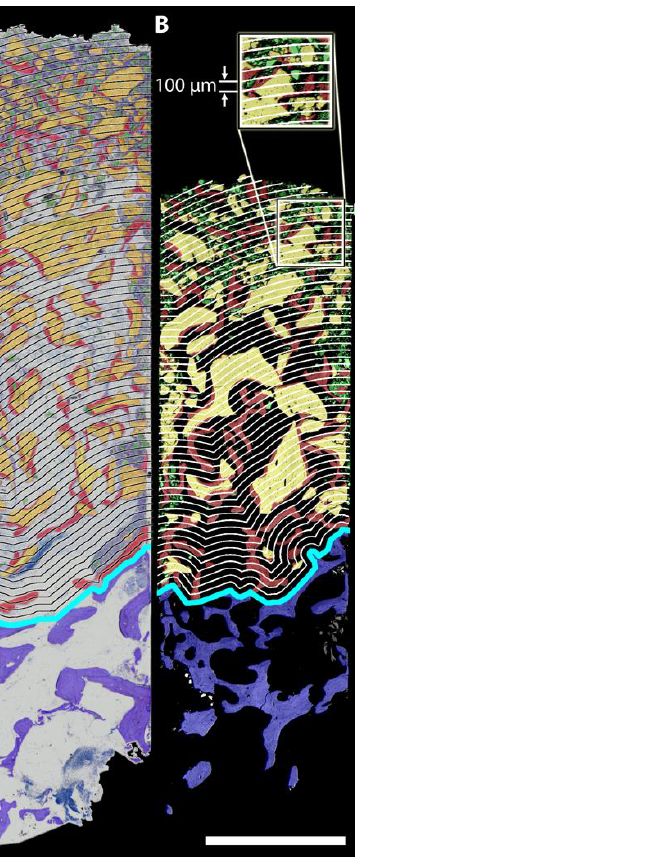
Figure 1. Histological thin-ground section ( A ) and a SEM image ( B ) superimposed with colour-coded classification images to illustrate the vertical distribution of BS particles within the augmented area. Blue: native bone of the sinus floor, red: newly formed bone, yellow: bone substitute particles, green: debris, in-between: marrow area/soft tissue; turquoise: borderline between the sinus floor (SF) and the augmented area. In parallel to the turquoise line, contour lines were set at an interval of 100 μm to measure the histomorphometric parameters within each of the resulting serial zones: bone substitute volume fraction (BSV/TV), number of BS particles (BS.N), average size of BS